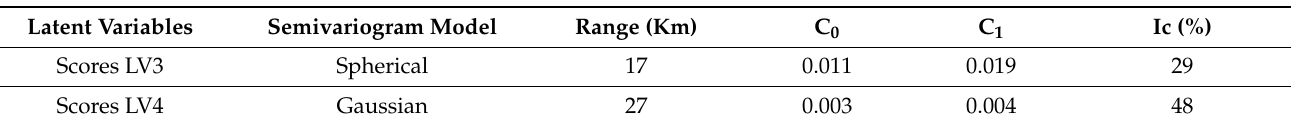
Table 4. Semivariogram parameter descriptors and spatial variability index for score values A 1 (Range), C 0 (Nugget), C 1 (Sill) and I c : Cambardella Index.